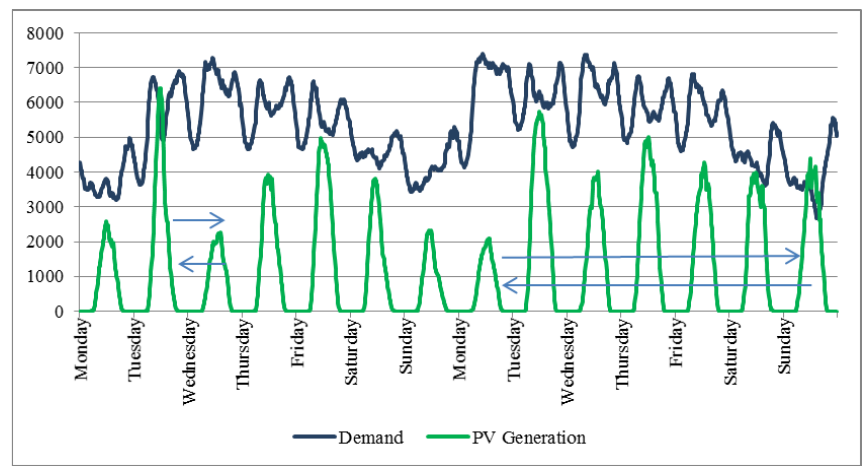
Figure 3. Theoretical displacement of the PV generation curves in order to achieve the best scenario (2nd condition) for CD PVMAX . Real data corresponding to Transnet network (9–22 April 2012).